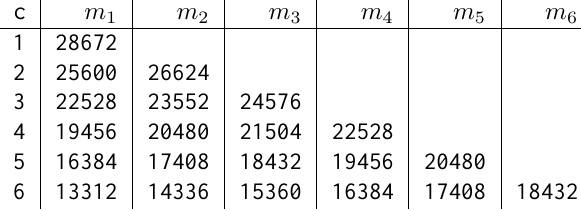
Tab. 3: Possible Number of Cache Misses for WHT